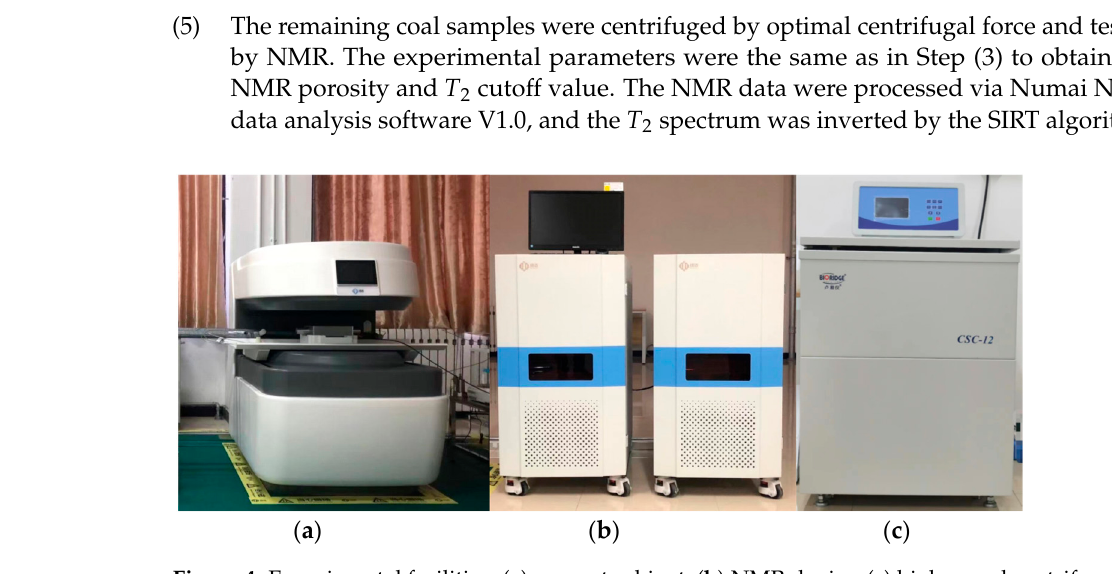
Figure 6. Relationship between centrifugal force and pore water content. In Figure 6, the water content of adsorption pores decreases greatly when the centrif- ugal force increases from 0.53 MPa to 1.19 MPa. When the centrifugal force increases from 1.19 MPa to 1.46 MPa, the water content of adsorption pores is less than 3%. The water content of percolation pores and migration pores does not change obviously when the centrifugal force is greater than 0.53 MPa. The expected experimental results were achieved at a centrifugal force of 1.46 MPa. In addition, Yang et al. [37] conducted centrif- ugal experiments on coal samples and selected 1.46 MPa as the best centrifugal force. This result is consistent with the centrifugal force we selected, indicating that the centrifugal experiment is effective. Based on 1.46 MPa centrifugal force, NMR experiments were per- formed on the remaining seven coal samples before and after centrifugation. 4.2. Calibration of T 2 Cutoff Values Figure 7 shows the comparison of NMR responses of samples under the saturated state and the bound water state after centrifugation. Coal samples before and after the centrifugal T 2 spectra have the characteristics of the three peaks. In Figure 7, S2 and S3 belong to a whole, and their corresponding pores are well connected. S1 is independent of S2 and S3, and the connectivity between adsorption pores and other pores is poor. After centrifugation, the peak of S1 did not decrease significantly, while the peak of S2 and S3 decreased significantly. The corresponding peak values of S2 and S3 are accompanied by a trend of rightward migration. This is the performance of water flowing from partial